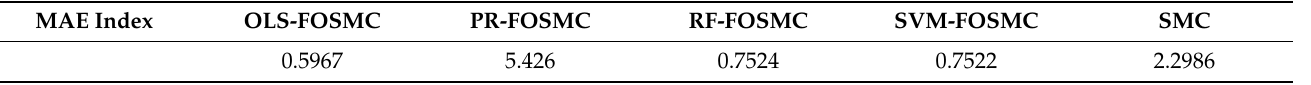
Table 4. Comparison of transient performance of the proposed controllers based on ML and the SMC using the MAE